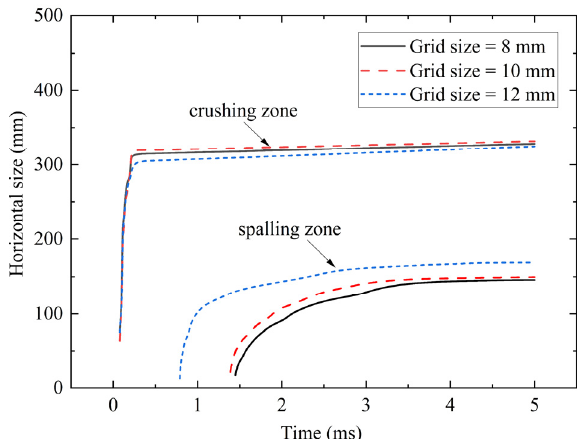
Figure 9. Mesh convergence